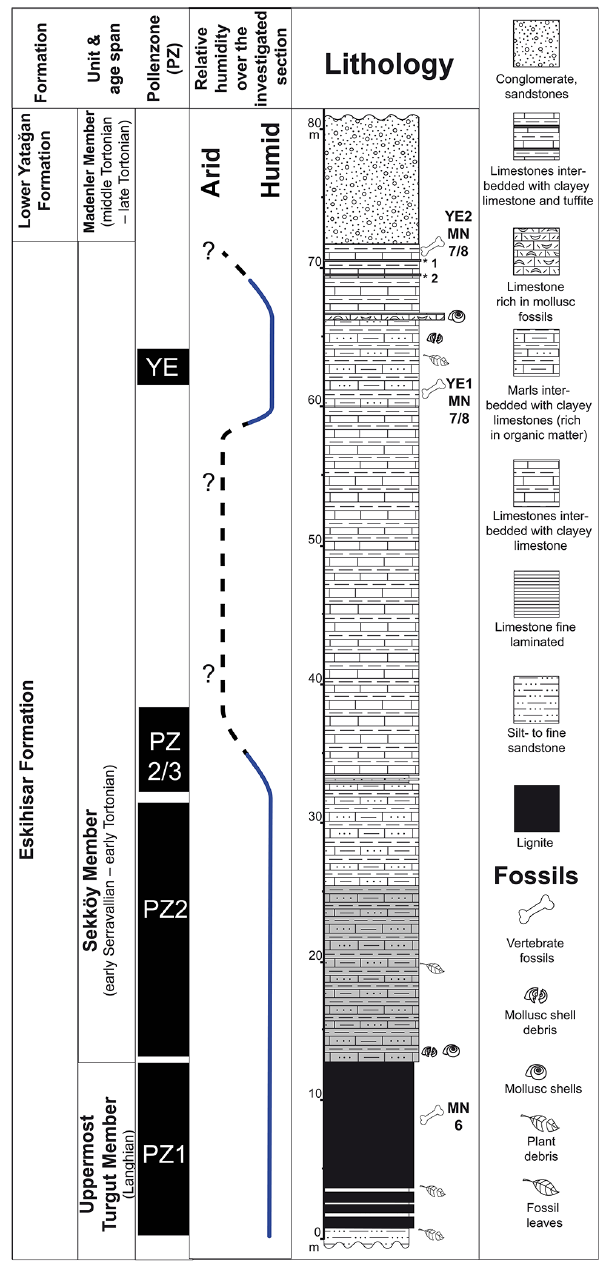
Figure 2. Generalized lithostratigraphic column for the Eskihisar lignite mine and pollen zones (PZs). The main part of the inves- tigated plant macrofossils originates from ca. 10m thick deposits overlying the exploited lignite seams (part of the section highlighted in grey corresponding to PZ 2). Yeni Eskihisar 2 (YE2) and Yeni Eskihisar 1 (YE1) vertebrate fossil localities (Becker-Platen et al., 1977). Radiometrically dated tuff layers (*): 1* – 11 . 2 ± 0 . 2Ma; 2* – 13 . 2 ± 0 . 35Ma (Becker-Platen et al.,